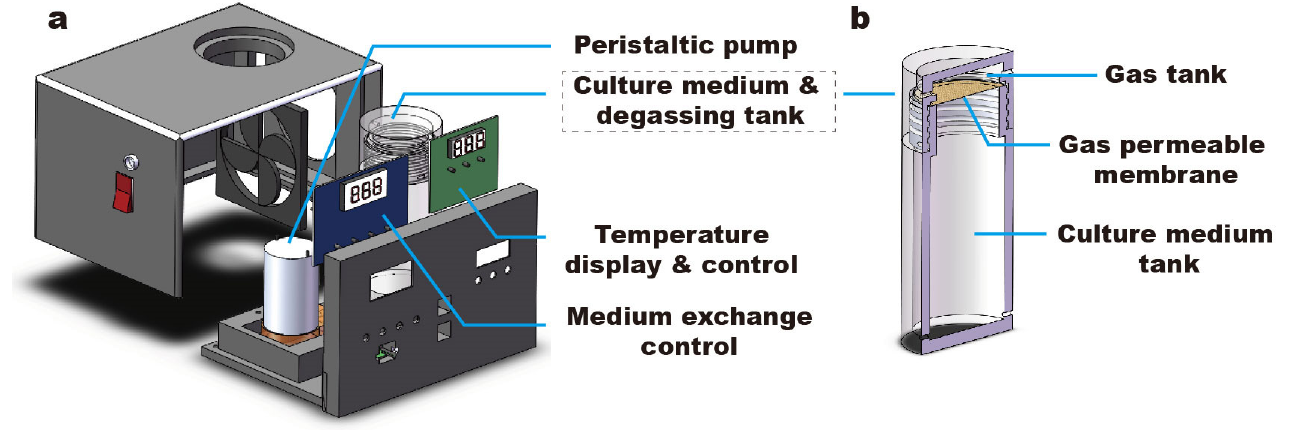
Figure 2. Design of control unit. ( a ). The control unit. ( b ). The water tank of control unit, in which the gas tank and the culture medium tank are separated by a gas-permeable membrane.